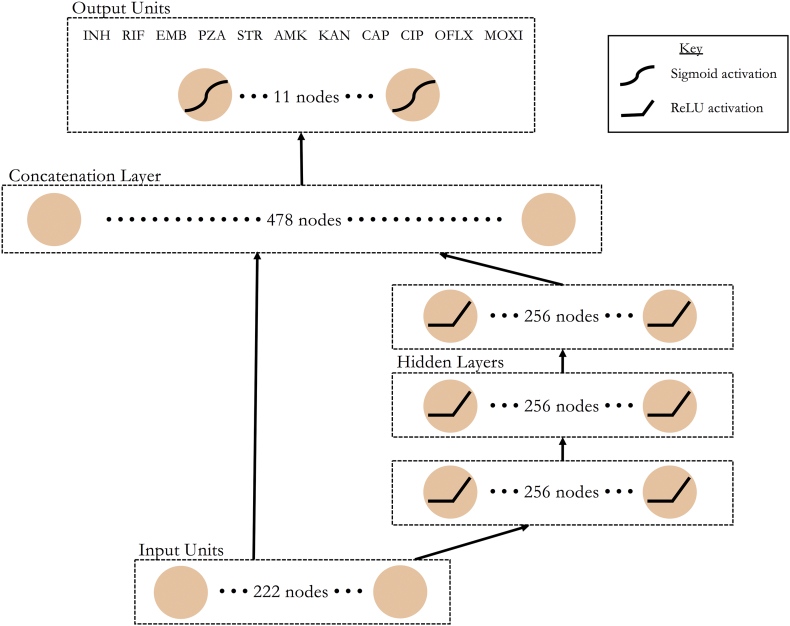
A schematic of the multidrug wide and deep neural network architecture. Data flows from bottom to top through the wide (left) and deep (right) paths of the neural network. Nonlinear transformations, where applied, are depicted on the corresponding nodes. Each of the 11 nodes in the output layer represents resistance status predictions in all MTB isolates for one of the 11 anti-tuberculosis drugs.